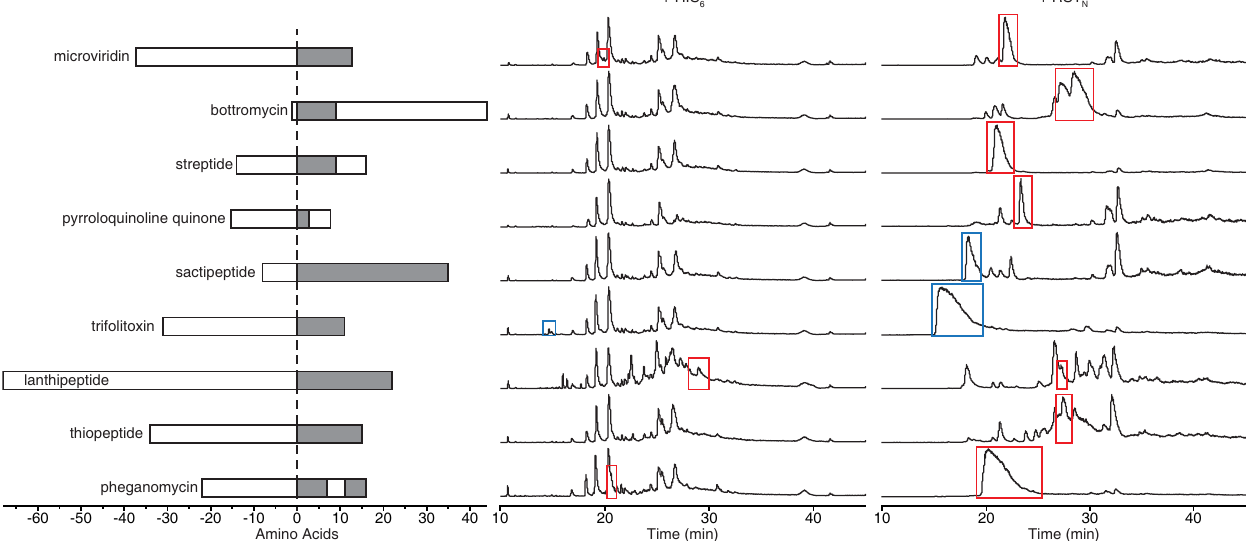
Fig 2. RST N stabilization of unmodified peptides from diverse RiPP classes. The peptide schematics show precursor peptide structural elements (leader/ follower, white box) and core (grey box). From top to bottom, the gene names (species) are: mdnA , bmbC , strA , pqqA , sboA , tfxA , procA1 . 7 , tbtA , pgm2 . The LC-MS total ion chromatograms are shown (Methods). Peaks boxed in red match peptide expected mass, blue match the expected mass of a peptide cleavage product. Masses are provided in S1 Table. In +HIS 6 column, top-to-bottom, extracts are 192, 193, 194, 195, 196, 198, 199, 200, and 202. In +RST N column, top-to-bottom, extracts are 216, 220, 219, 218, 217, 221, 222, 223, and 225. For these experiments, the initially designed RST N variant with Link-1 was used. The chromatograms are representative of two replicates that yielded similar results (the second performed with the high-throughput expression/purification protocol,